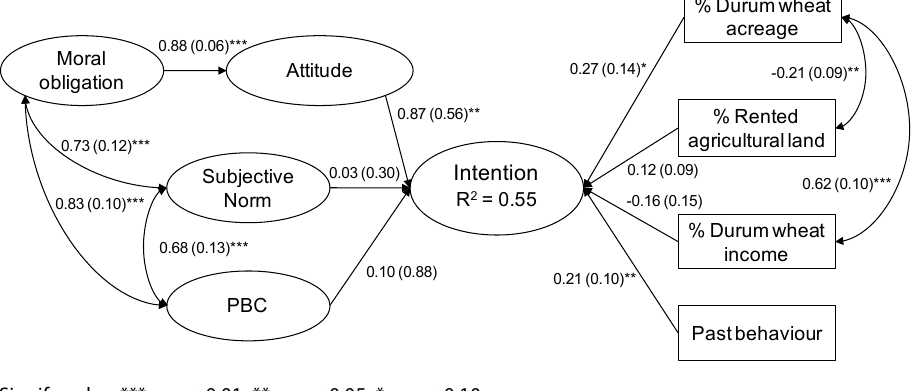
Figure 2. Structural equation model results, behaviour 1 “Ecological focus area”: R-squared, standard- ised coefficients, correlations and standard errors (in